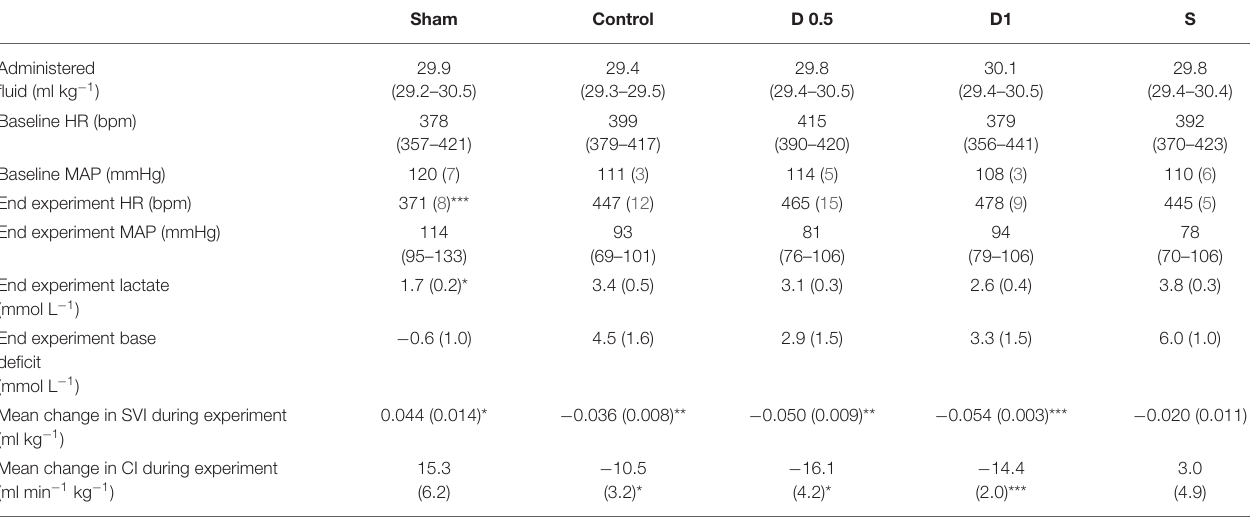
TABLE 1 | Fluid administered, temporal changes in blood gas and haemodynamic parameters for each group ( n = 6 all groups). Sham Control D 0.5 D1 S